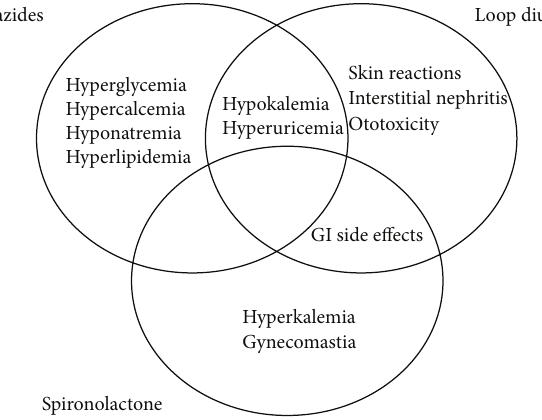
Figure 2: Adverse effects of major diuretics [11, 12,